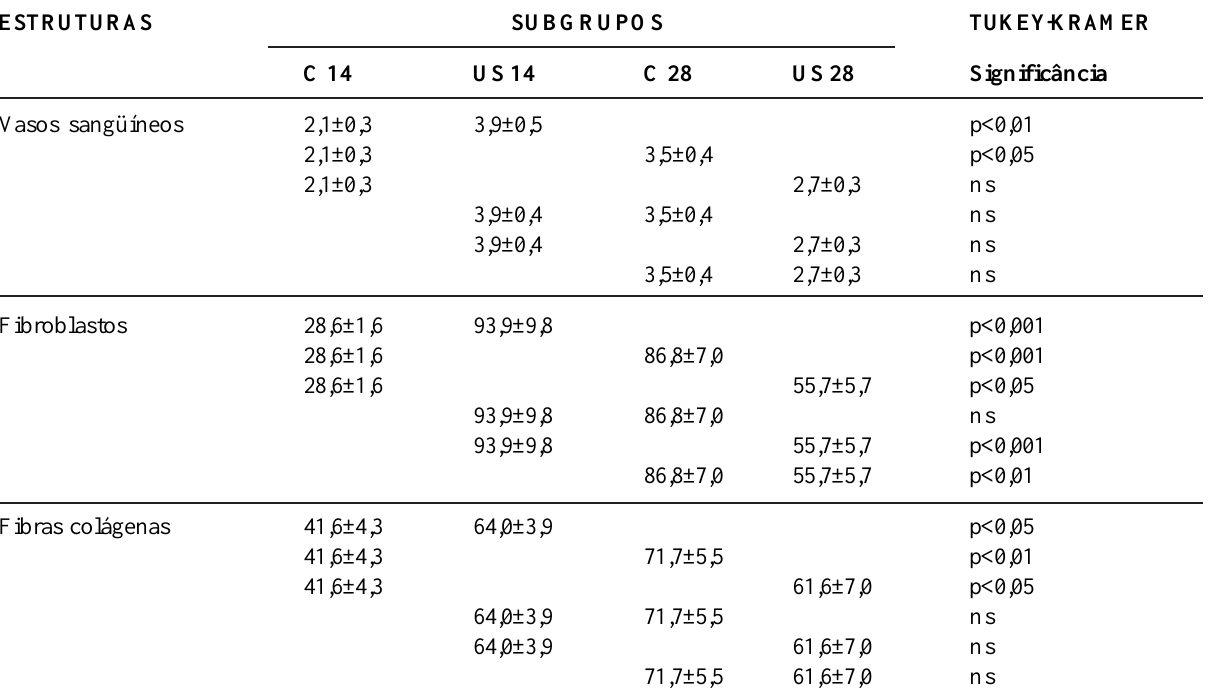
TABELA 2 – Valores médios e erro padrão, por subgrupo, da densidade de vasos sangüíneos, fibroblastos e fibras colágenas no saco herniário ou na cicatriz da linha